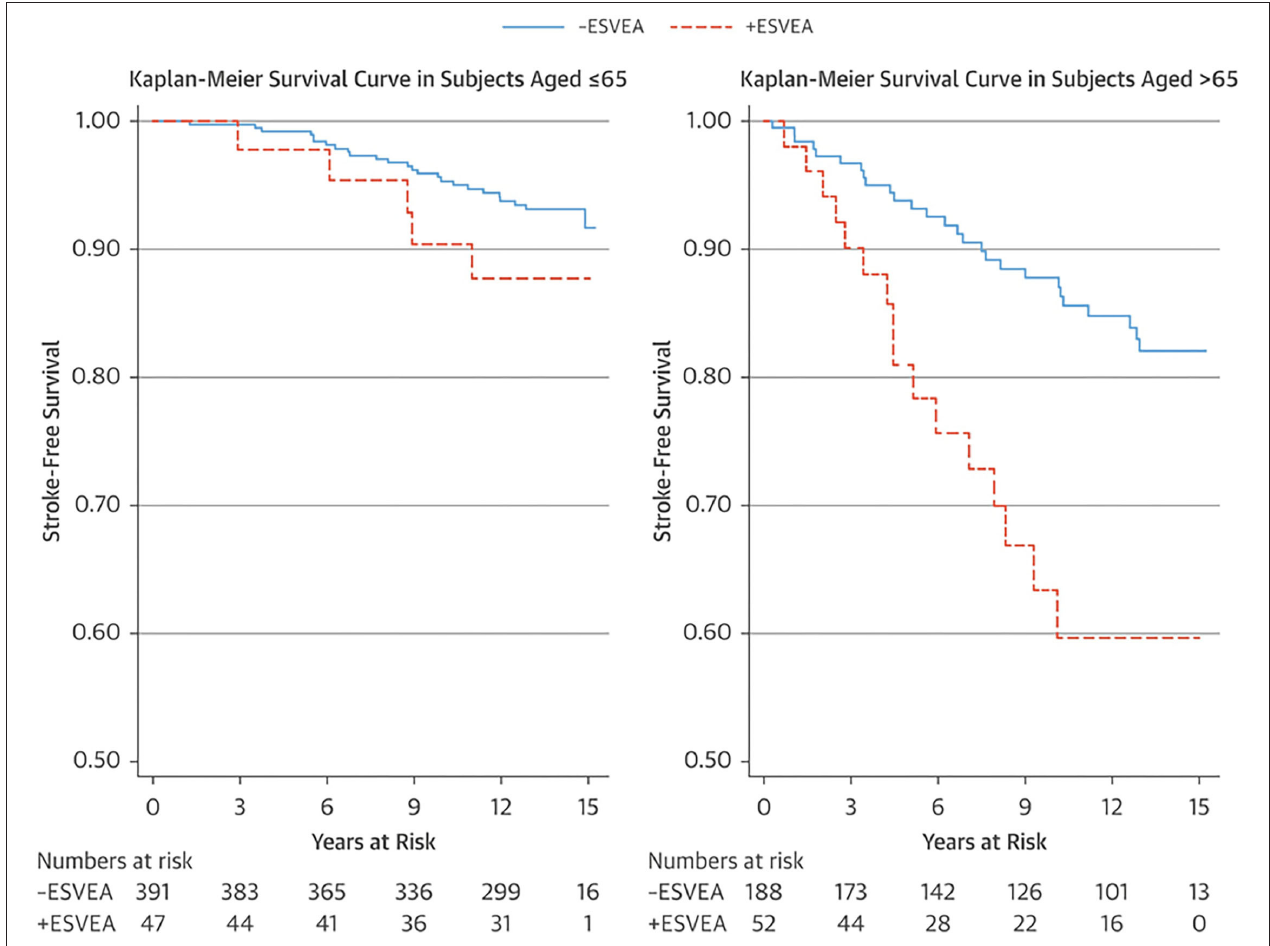
FIGURE 4 | Kaplan–Meier survival estimate of stroke-free survival stratified by age group and ESVEA (18). The incidence of stroke associated with ESVEA was higher in patients > 65 years of age ( p = 0.0007), but not in patients ≤ 65 years of age ( p = 0.2086). ESVEA, excessive supraventricular ectopic activity.